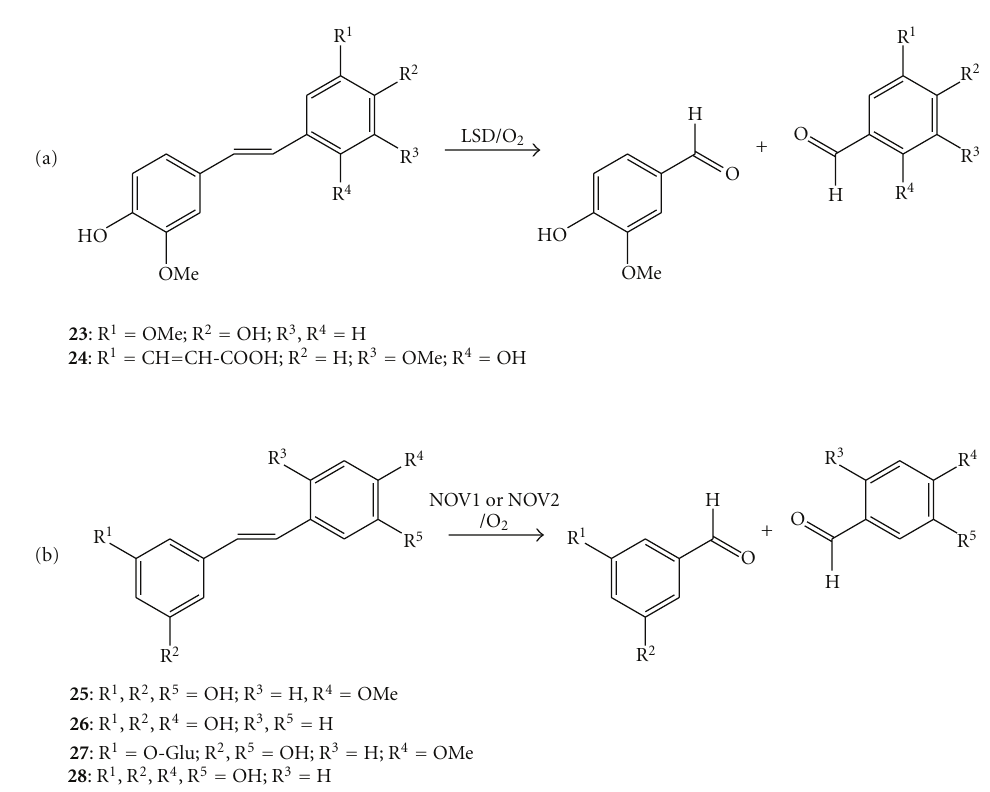
Scheme 10: Alkene cleavage of stilbene derivates: (a) alkene cleavage catalysed by the isoenzymes of lignostilbene α , β -oxygenase from Sphingomonas paucimobilis TMY 1009; (b) alkene cleavage catalysed by stilbene monooxygenases from Novosphingobium aromaticivorans DSM 12444 NOV1 and